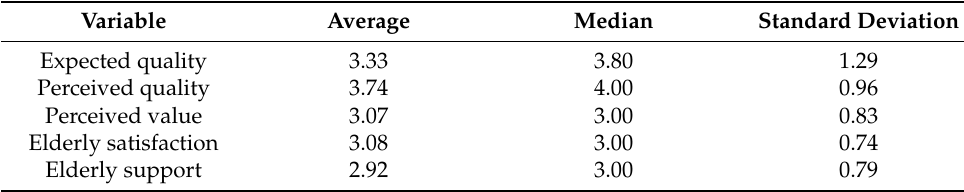
Table 3. Descriptive statistics of the latent variables.